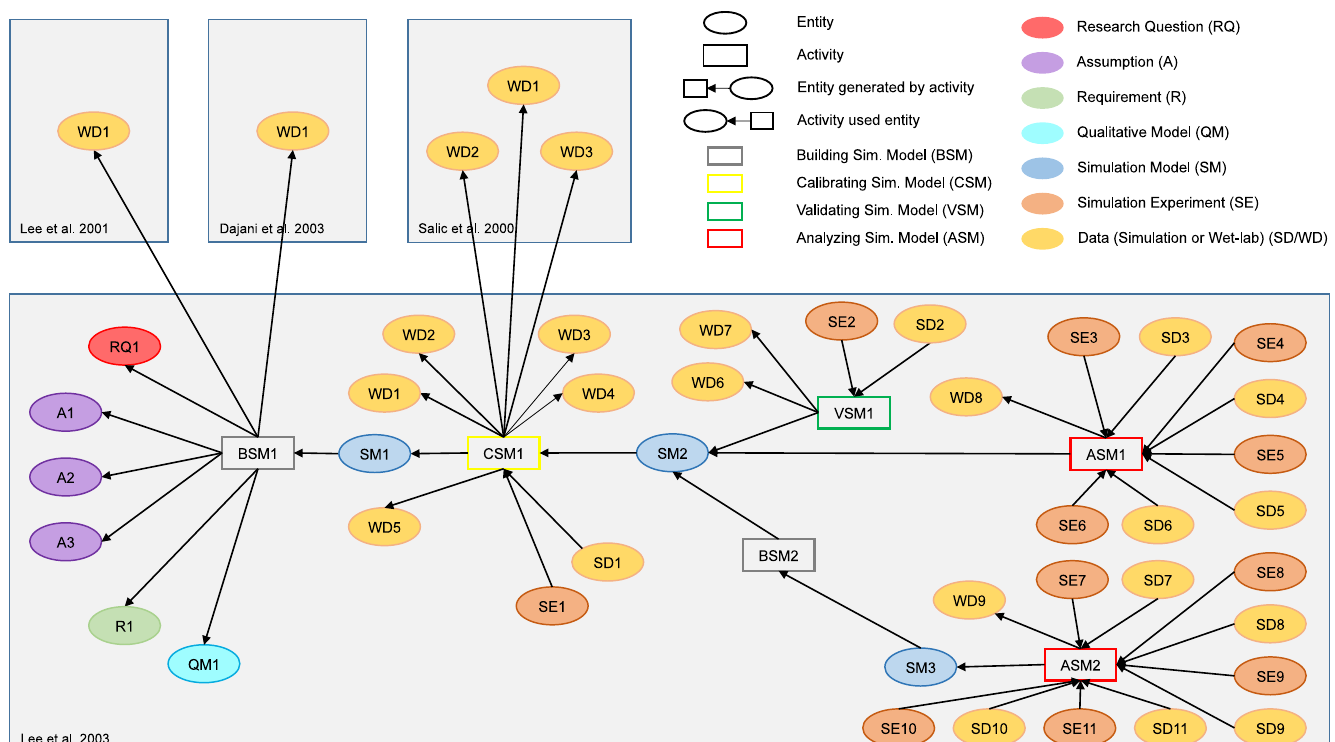
Fig 3. Provenance graph of the study by Lee et al. (2003) [28]. Besides the entities and activities that make up the provenance information from the study (see legend), additional entities from three other studies [64–66], which were used by Lee et al. (2003), are shown. The colors of the ellipses show different entity types, the borders of the rectangles visualize different activity types. The gray areas separate the individual studies. The graph displays, for example, that the Building Simulation Model activity BSM1 used, among others, the entity WD1 of type Wet-lab Data from Lee et al. 2001 [64]. This activity then generated the Simulation Model SM1 .